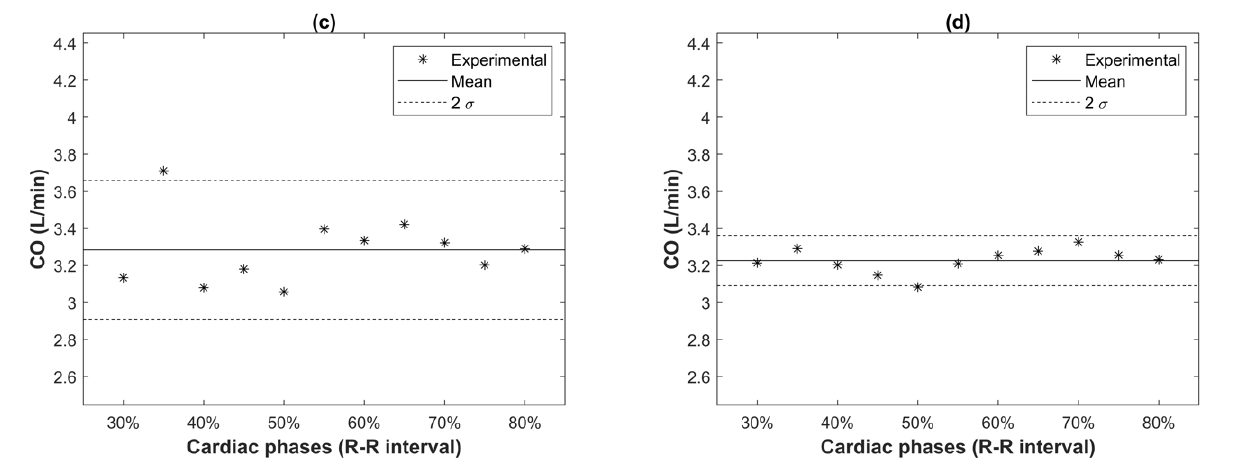
Figure 4. Two curve normalization approaches for assessment of CO index in a pig study—baseline subtraction using ( a ) the averaged value of all baseline data points and ( b ) only the baseline data point unaffected by streak artifacts. The curves shown in ( a , b ) were acquired from a pig at different cardiac phases, ranging from 30% to 80% of the R-R interval, with each cardiac phase represented by a color illustrated in the color-coded bar adjacent to the graphs. The estimated CO indexes corresponding to the two curve normalization approaches are shown in ( c , d ), respectively. The CO indexes estimated with the second normalization approach among different cardiac phases were less deviated from each other.